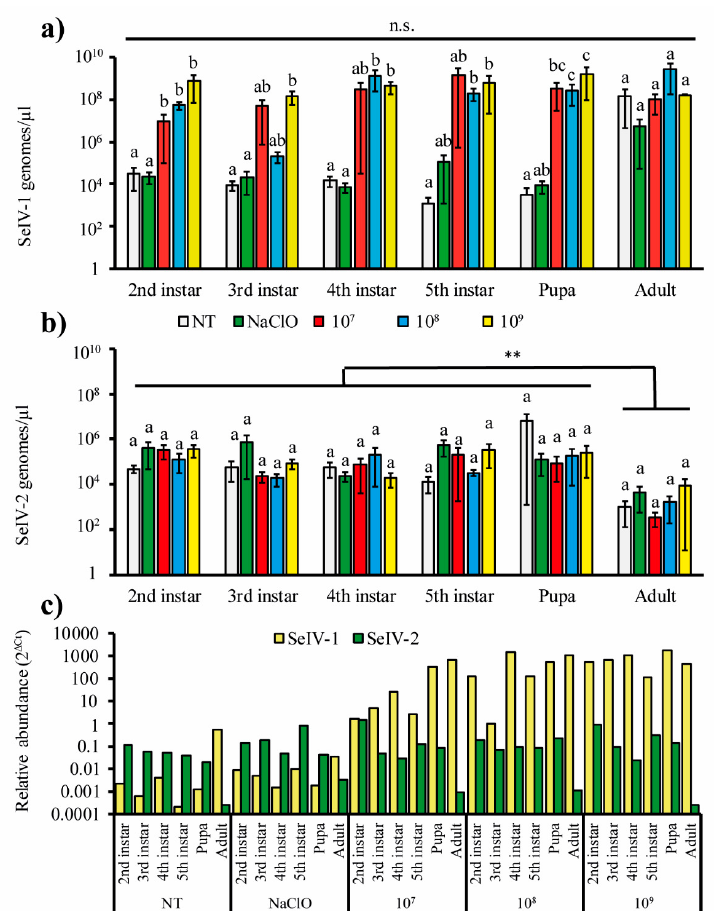
Figure 1. Quantification of titers of ( a ) Spodoptera exigua iflavirus 1 (SeIV-1) and ( b ) SeIV-2 in the developmental stages of Spodoptera exigua . Viral loads were estimated by quantitative PCR (qPCR) for insects that hatched from egg masses that had been treated with 10 7 , 10 8 and 10 9 genomes/µL of a mixture of SeIV-1 and SeIV-2 (time-course experiment). The control egg masses were not treated (NT) or treated with hypochlorite solution (NaClO). Vertical bars indicate SE. Columns headed by different letters differ significantly for comparisons of treatments within each developmental stage (ANOVA, Tukey p < 0.05). Horizontal lines indicate comparisons among developmental stages in ( a ) and ( b ). n.s. indicates not significant, whereas ** indicates significant difference (ANOVA, p < 0.01). ( c ) Relative abundance (mean 2 Δ Ct values) of SeIV-1 and SeIV-2 in insect samples calculated with reference to Ct values for the ATP-synthase reference gene. To control for host growth effects, SeIV-1 and SeIV-2 titers were normalized with reference to ATP-synthase gene expression (Figure 1c). SeIV-1 expression exceeded the reference gene expression levels in all iflavirus treatments except for the NT control or hypochlorite treatment insects, indicating a positive relationship between viral replication and developmental stage. SeIV-2 replication did not